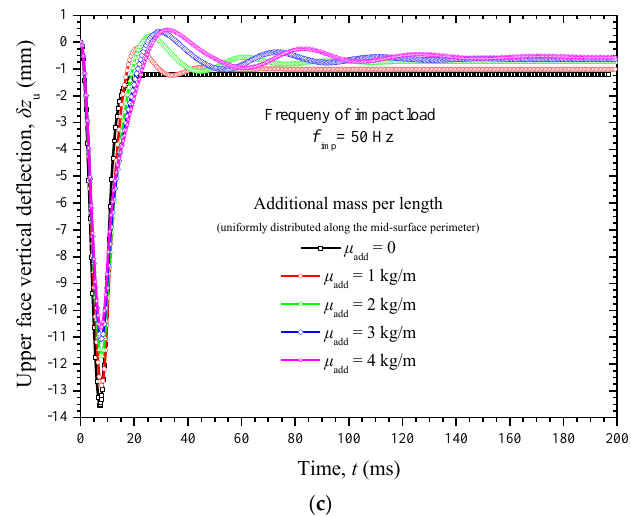
Figure 11. Time variation of the upper face vertical deflection under a half − sine impact shock characterized by a frequency of ( a ) 30 Hz, ( b ) 40 Hz, and ( c ) 50 Hz, for a variety of mass additions around the flywheel perimeter.